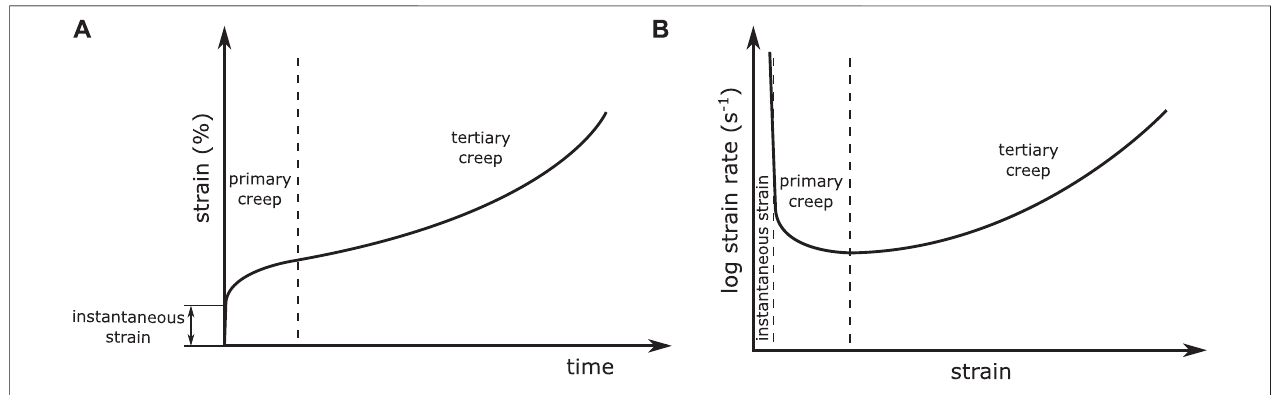
FIGURE 4 | Illustration of a creep curve that does not show a secondary creep